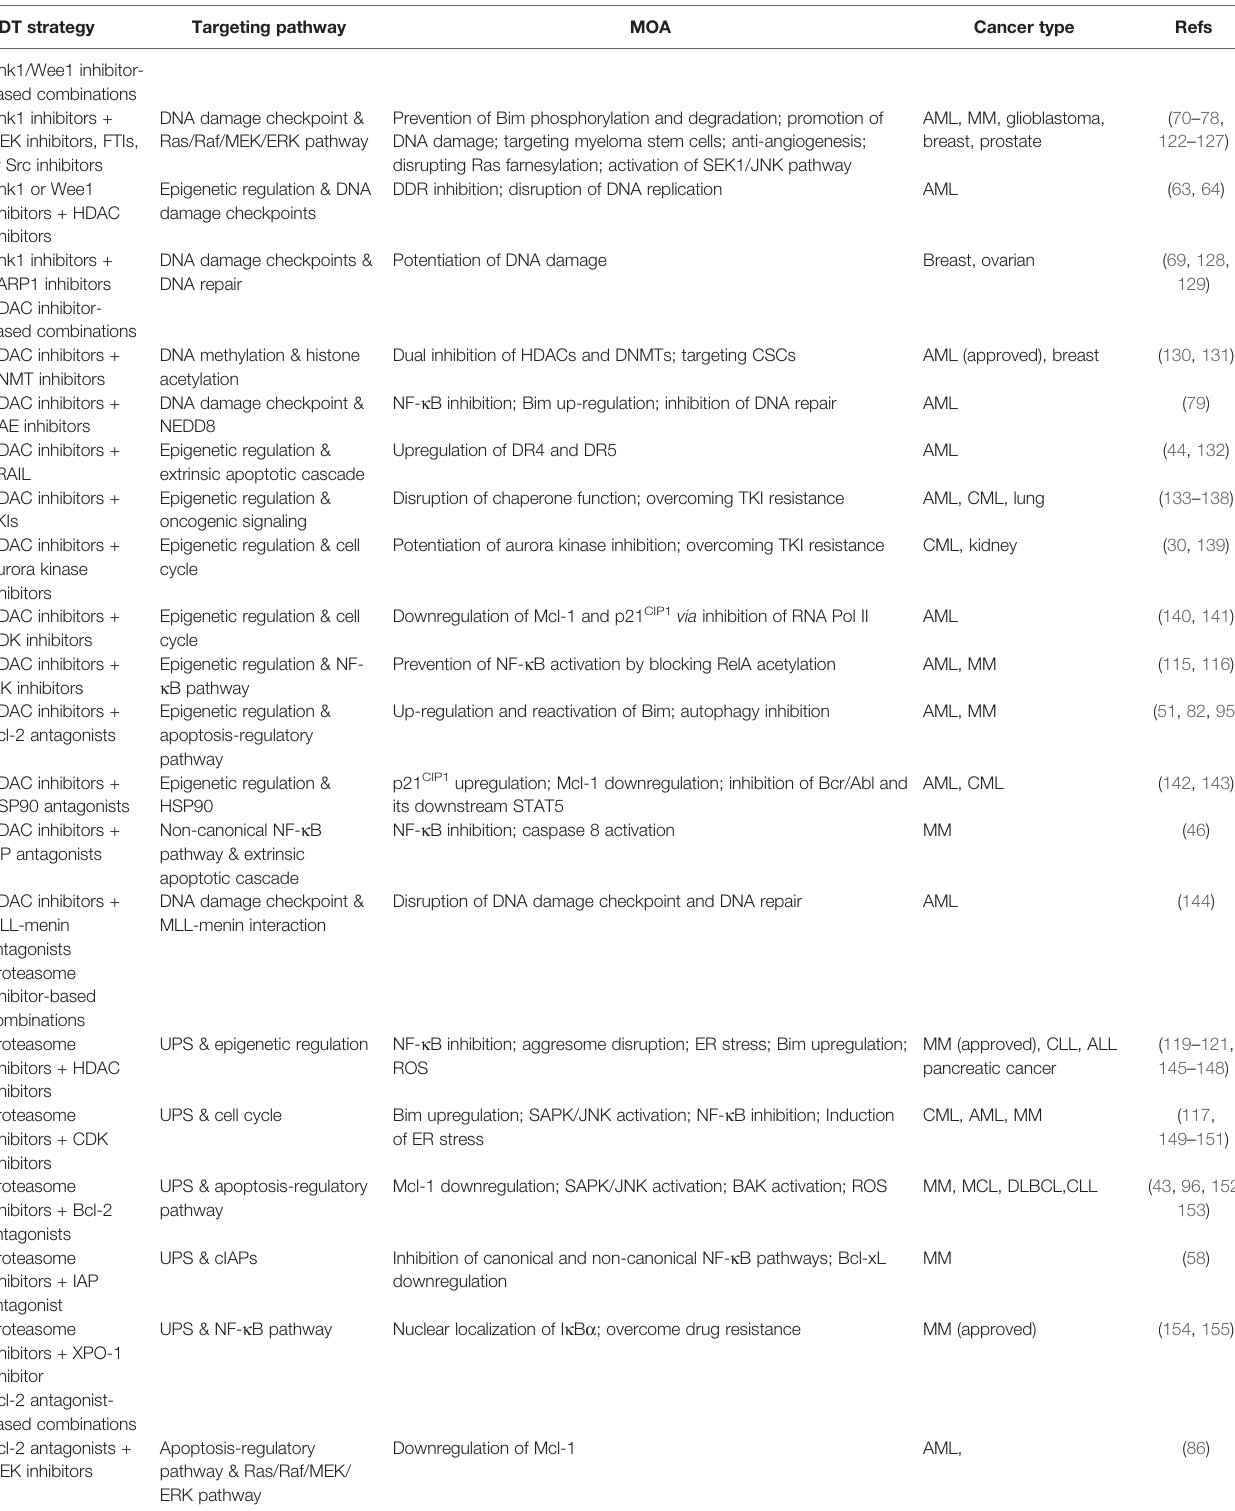
TABLE 1 | Dual-targeted therapy (DDT) in hematologic malignancies and other cancers.